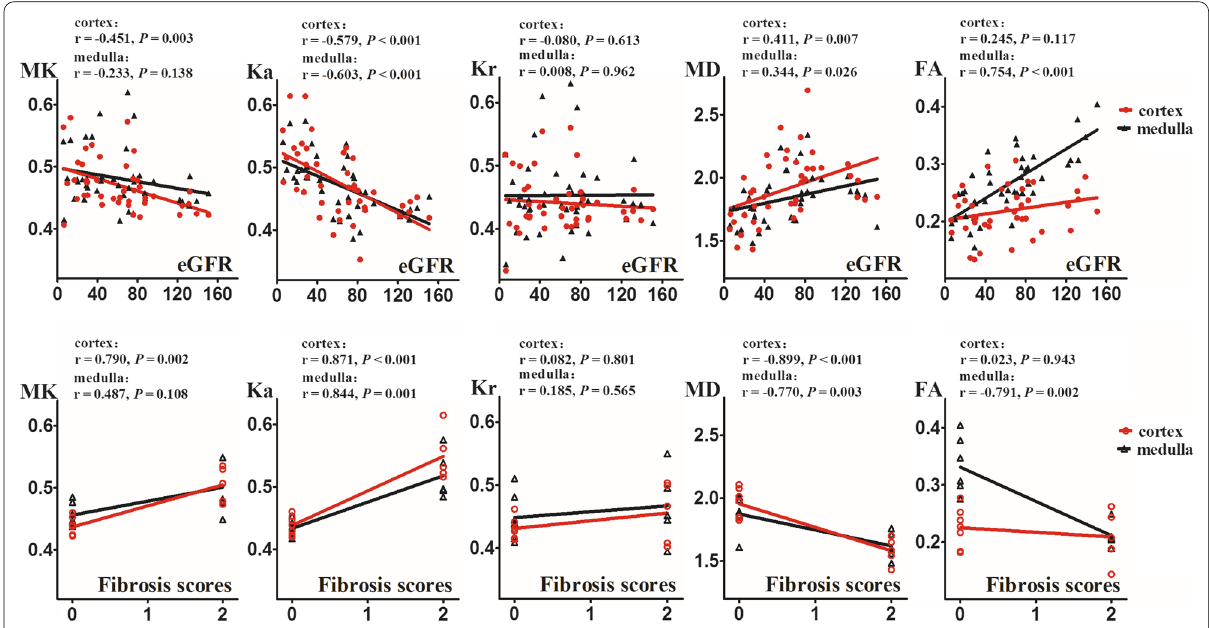
Fig. 4 Scatter plots of correlations between eGFR (upper row), fibrosis (lower row) and DKI metrics of renal cortex and medulla. eGFR, estimated glomerular filtration rate; DKI, diffusion kurtosis imaging; MK, mean kurtosis; Ka, axial kurtosis; Kr, radial kurtosis; MD, mean diffusivity; FA, fractional anisotropy